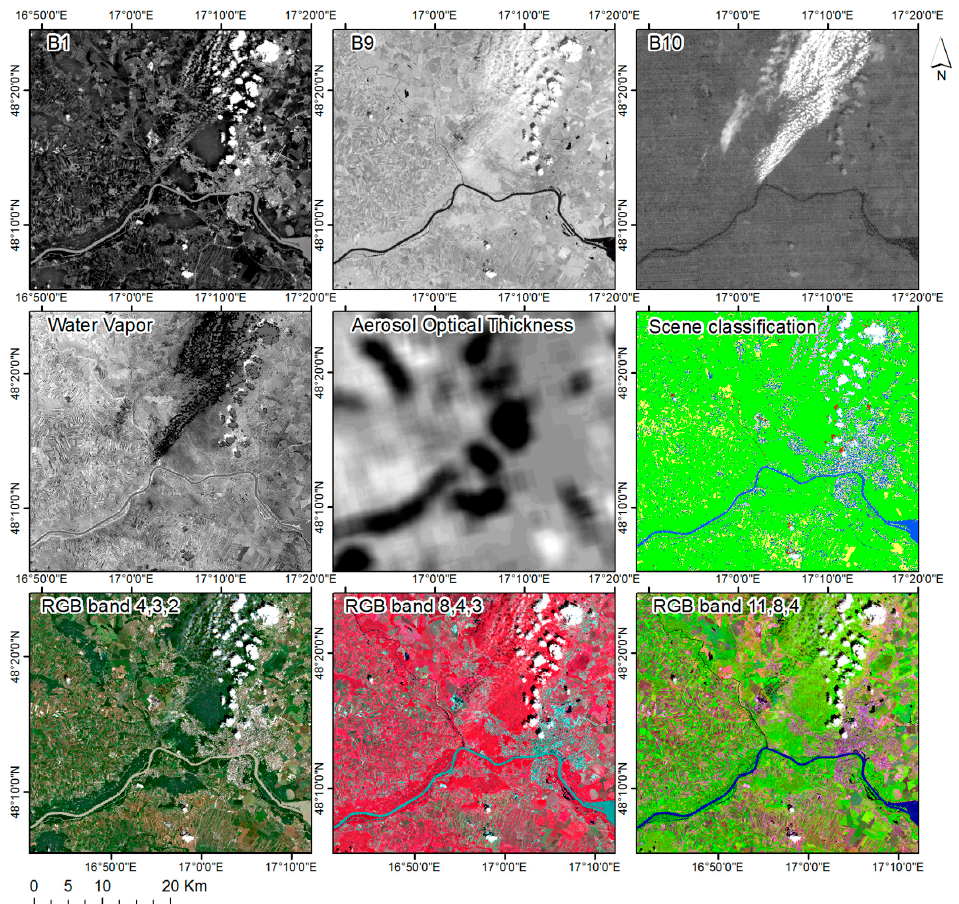
Figure 2. Examples of 60 m spatial resolution bands B1 (443 nm), B9 (940 nm), and B10 (1375 nm) dedicated to atmospheric correction and cirrus cloud detection (Sentinel-2 image subset acquired on 22 June 2016) and retrieved water vapor (WV) and aerosol optical thickness (AOT). On the bottom row, examples of true and false color RGB composites produced for the same acquisition are shown.